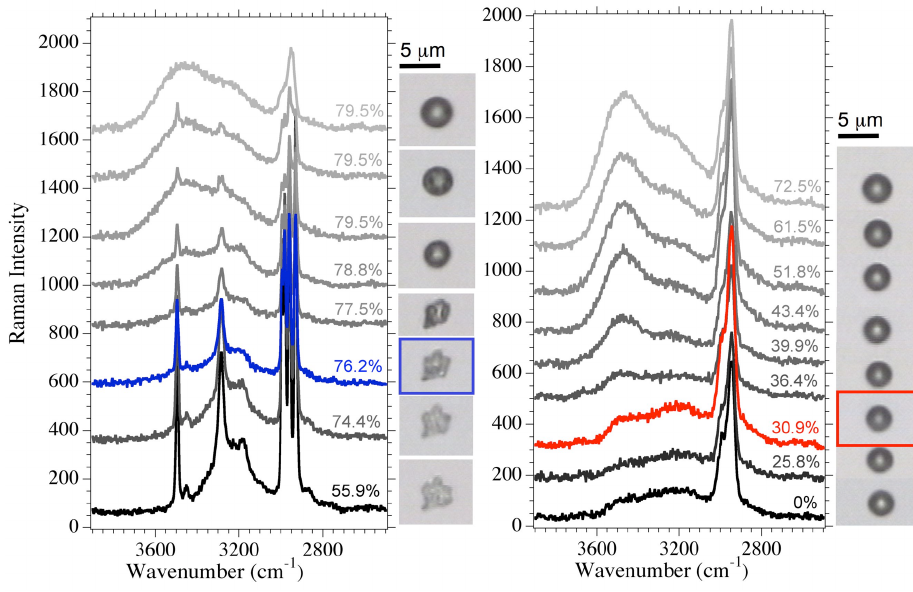
Fig. 1. Raman spectra and images demonstrating crystalline (left) and amorphous deliquescence (right) of a citric acid particle at 252 and 257 K, respectively. The onset of water uptake for each experiment was determined using spectral subtraction and indicated by spectra highlighted in blue and red. Spectral subtractions are given in Appendix A, Fig.